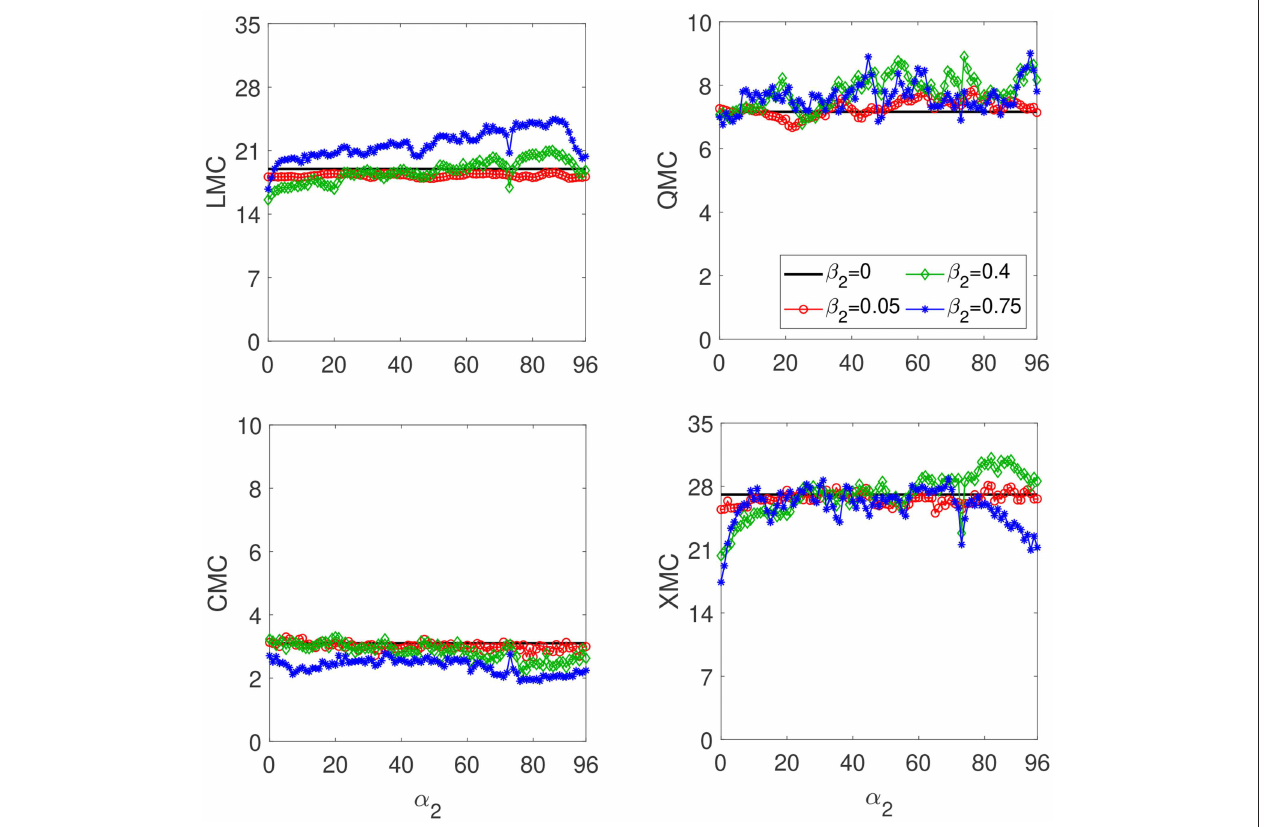
FIGURE 7 | Memory capacities for the two-delay-based RC as function of α 2 for a fixed α 1 = 73, T = θ/ 0.2 and γ = 0.1. The red circles, green diamonds and blue stars correspond to β 2 equal to 0.05, 0.4, and 0.75, respectively. The solid black line is for β 2 = 0 and corresponds to the one-delay case with α = 1 and β =